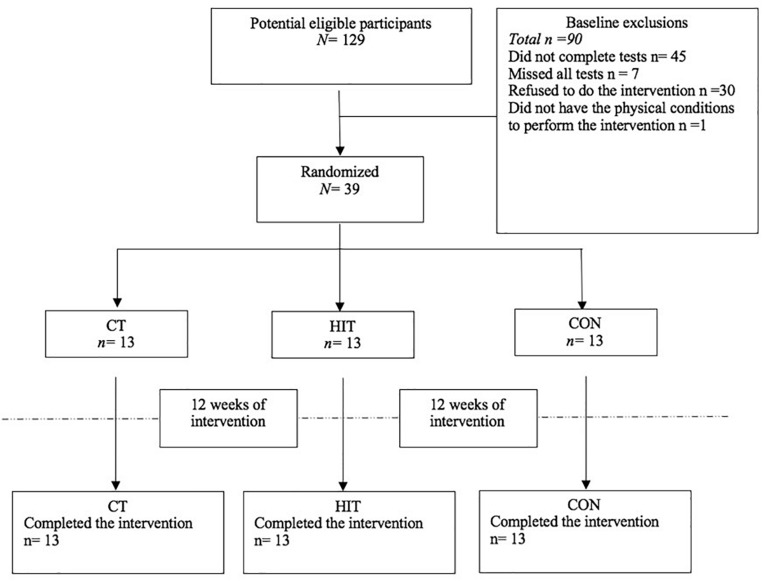
Cohort flux diagram.